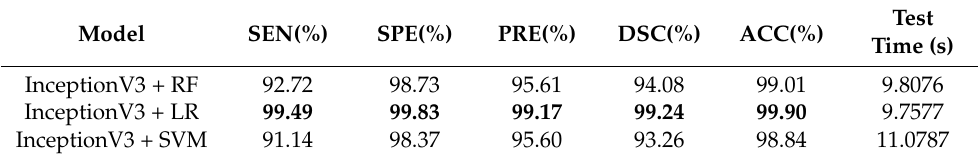
Table 6. The performance evaluation for InceptionV3 combined with different classifiers.